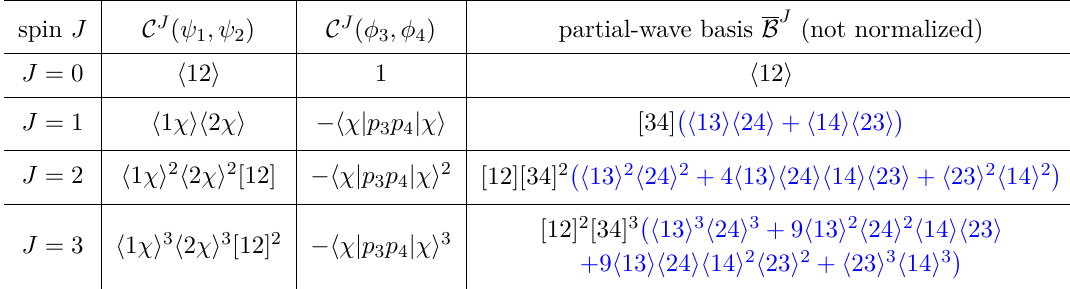
Table 2 . Partial-wave basis of process M ( ψ 1 , ψ 2 | φ 3 , φ 4 ) . χ is an auxiliary massive spinor associated with the total momentum P = p